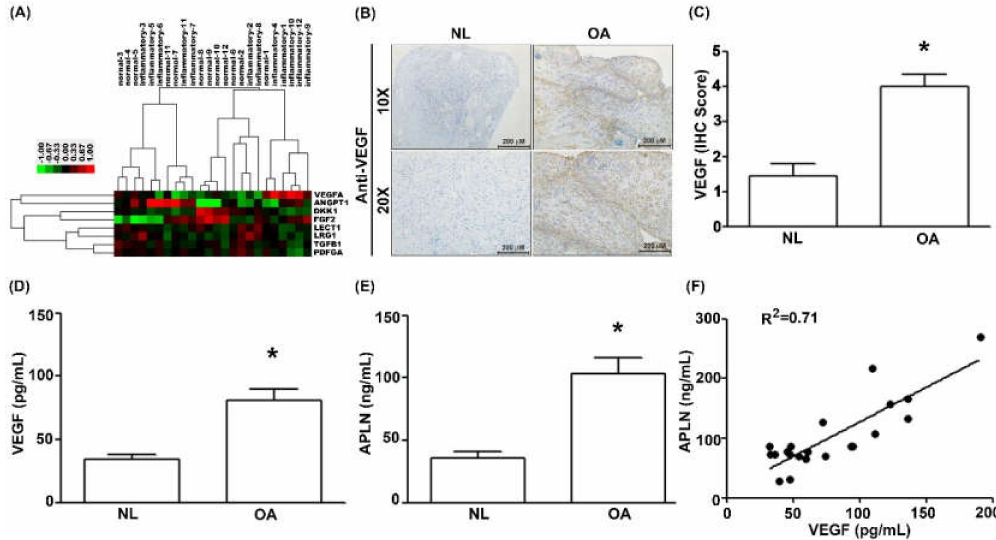
Figure 1. The expression of apelin (APLN) is positively correlated with the expression of vascular endothelial growth factor (VEGF) among osteoarthritis (OA) patients. ( A ) Expression levels of APLN were retrieved from the Gene Expression Omnibus (GEO) database records (accession code: GSE46750), which compares non-inflammatory areas to inflammatory areas of the synovium from 12 patients with OA. ( B , C ) IHC staining revealed higher levels of VEGF expression in OA synovial tissues ( n = 8) compared with non-OA tissues ( n = 5). ( D ) The ELISA assay revealed higher levels of serum VEGF expression among OA patients ( n = 21) compared with controls ( n = 21) and also ( E ) higher levels of serum APLN expression among OA patients compared with controls. ( F ) A positive correlation between VEGF and APLN expression in serum OA samples. NL = normal controls. * p < 0.05 compared with normal